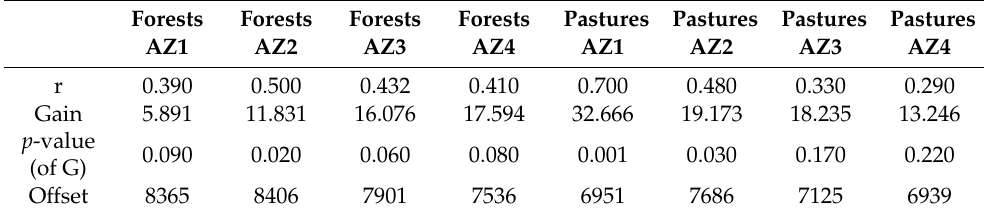
Table 9. First order polynomial coefficients of modeled trends computed for different altitudi- nal classes (AZs, see Table 4) of Forests and Pastures. Maximum Annual Normalized Difference Vegetation Index (MaxNDVI) values are ×